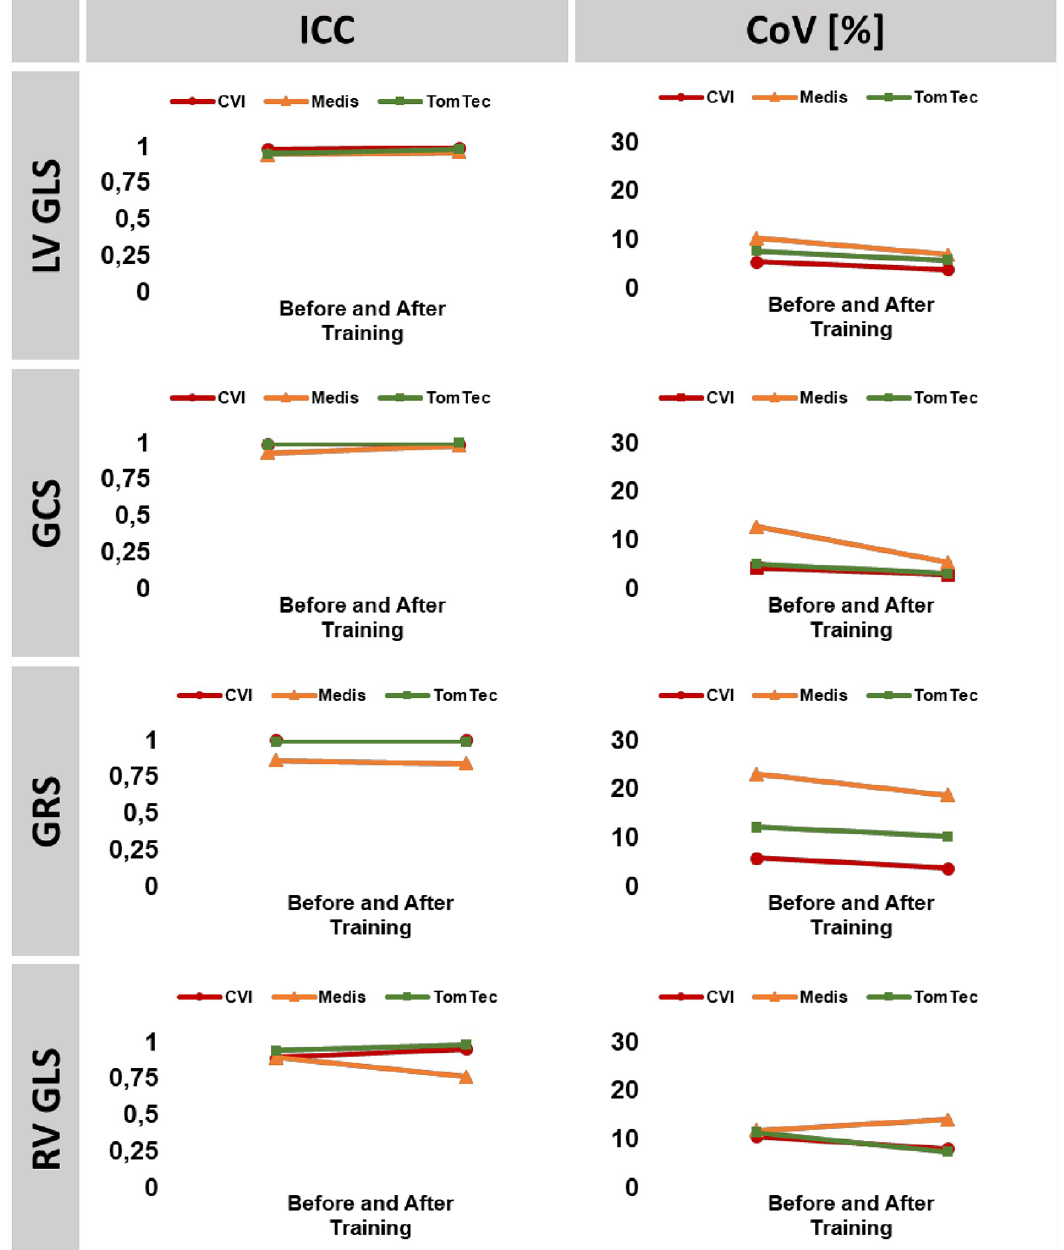
Fig 2. Intra-observer reproducibility. The graph shows interclass correlation coefficients (ICC) and coefficients of variation (CoV) for intra-observer reproducibility prior to and after training. LV/RV: left/right ventricle, GLS: global longitudinal strain, GCS: global circumferential strain, GRS: global radial